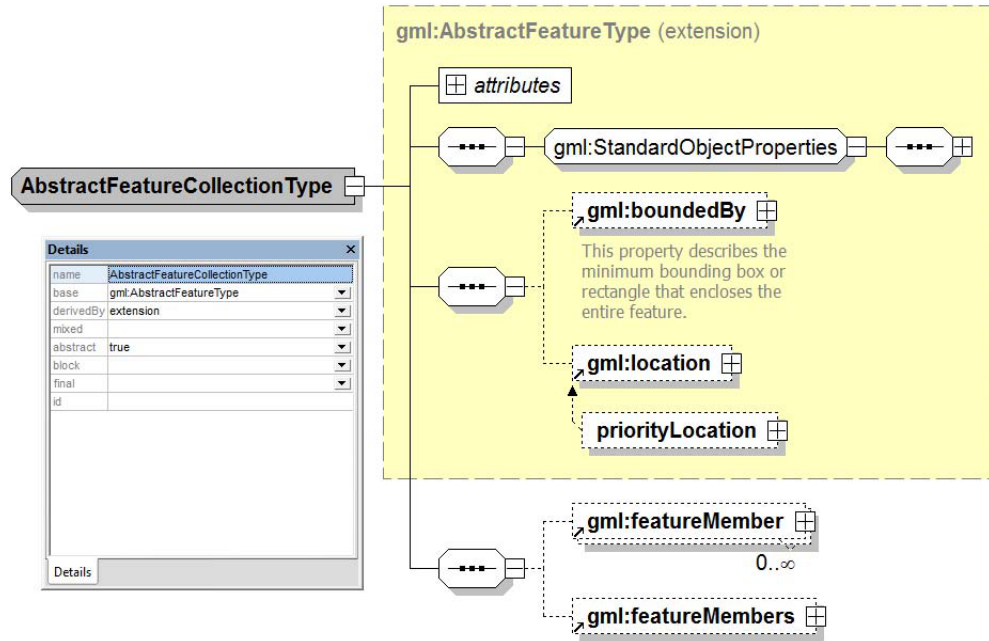
Fig. 10. The AbstractFeatureCollection schema diagram in